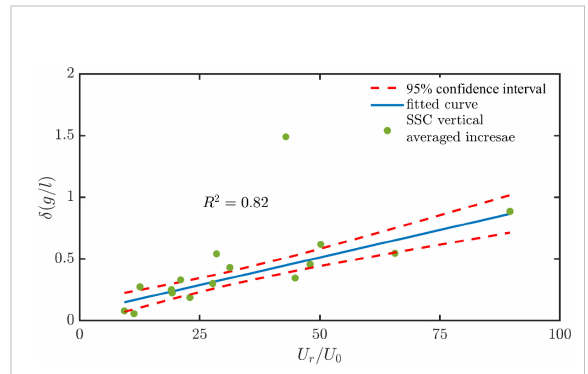
FIGURE 8 The SSC increments of various experimental cases verse the relative wind